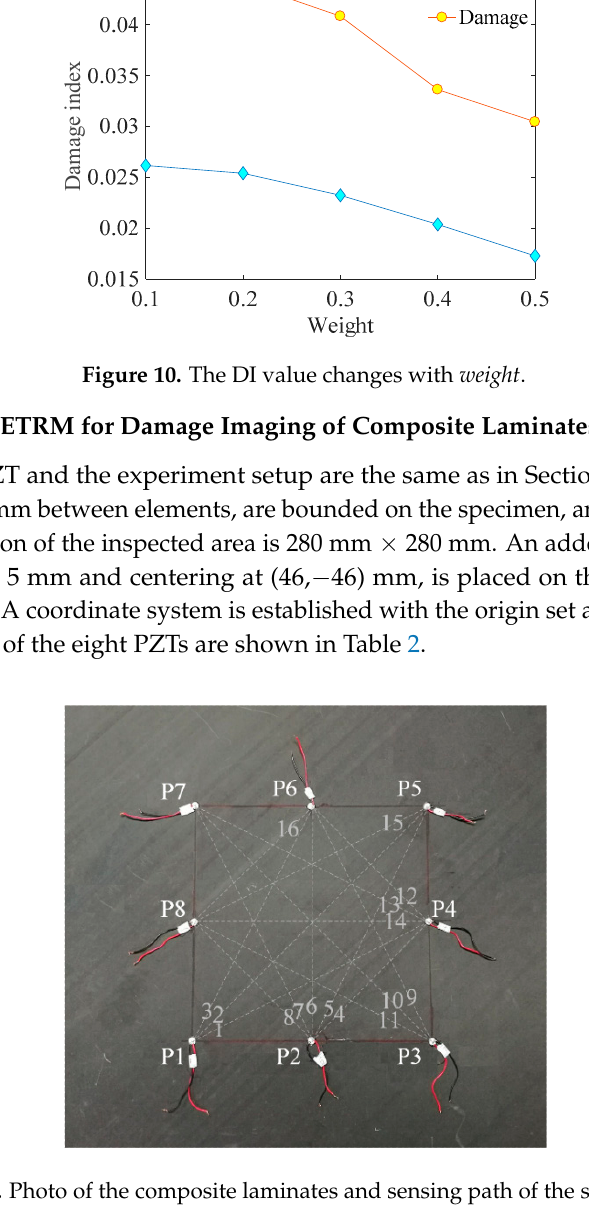
Figure 10. The DI value changes with weight .